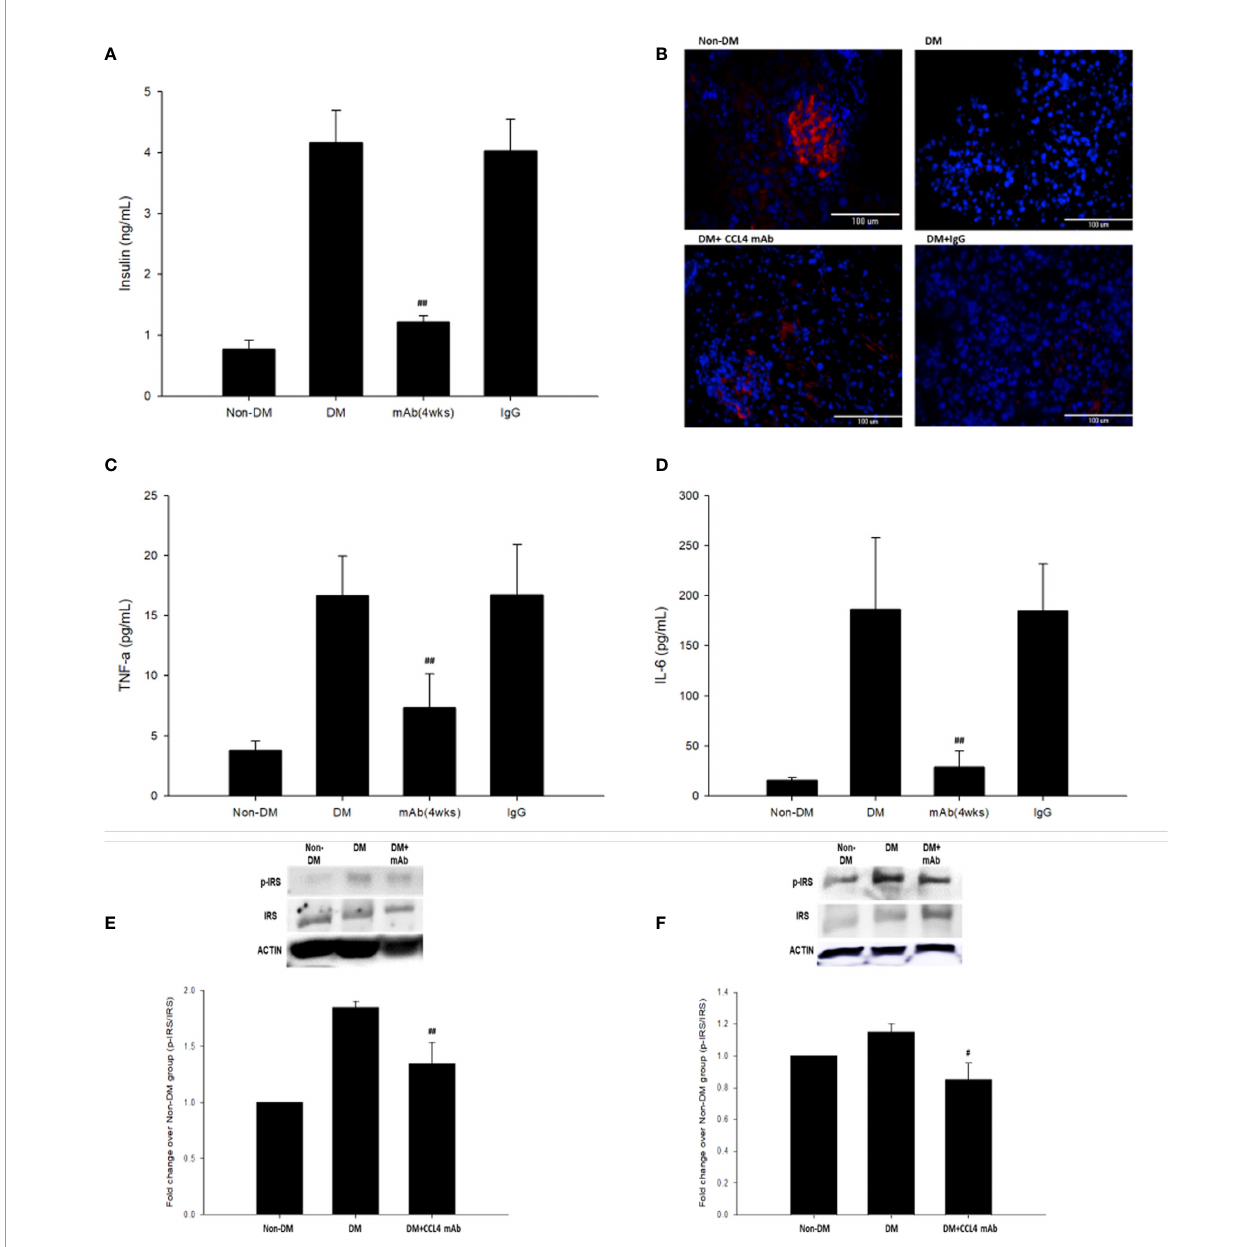
FIGURE 3 | The effects of CCL4 inhibition on pancreatic tissues from db/db mice. Serum insulin levels in db/db mice (n=6; A ). The CCL4 inhibition groups showed more insulin expression (red) in the pancreas than the IgG-treated diabetic db/db mice (B) . Serum TNF- a and IL-6 levels in db/db mice (n=6; C, D ). CCL4 inhibition prevented the increased phosphorylation of IRS-1 in skeletal muscle and liver tissues (n=3; E, F ) indicating the improvement of insulin signaling in db/db mice. # P <0.05, ## P<0.01 compared with DM+IgG mice (A, C, D) or untreated DM mice (E, F)